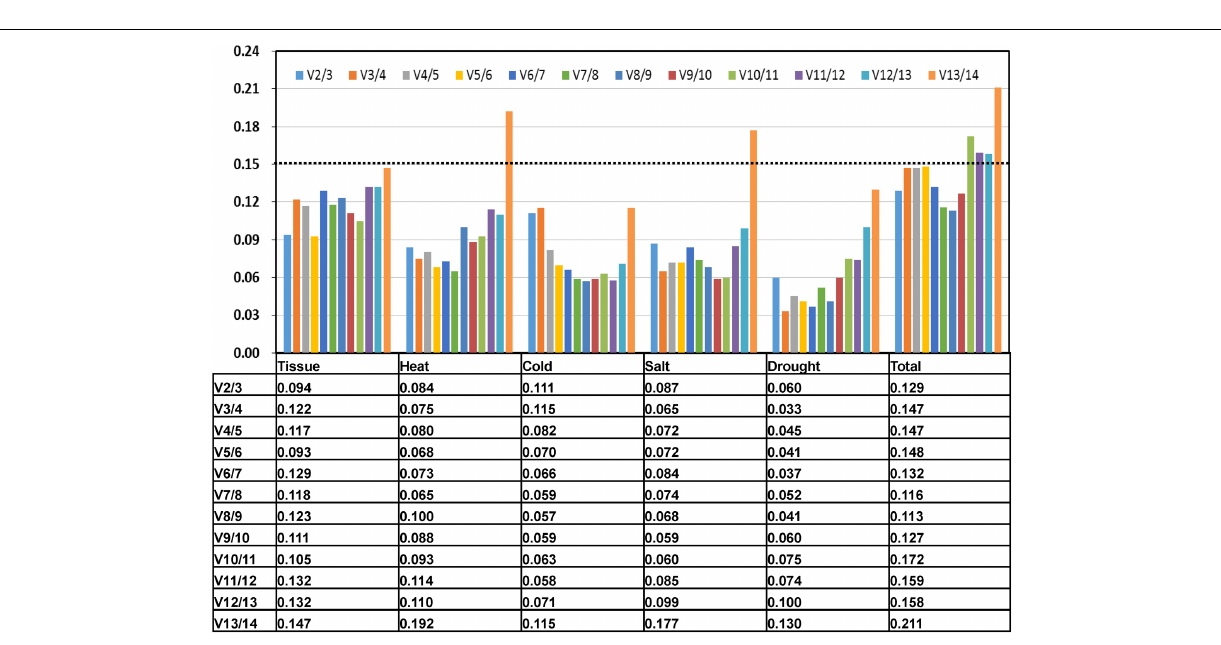
Frontiers in Plant Science |